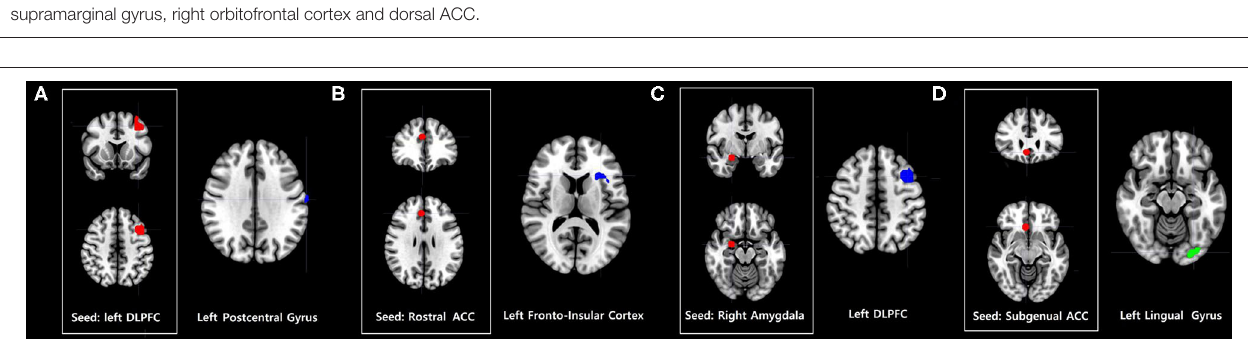
FIGURE 2 | Increases and decreases in seed-based FC among problematic smartphone users, compared to controls. All imaging analyses were corrected for multiple comparisons using a combination of voxel-level thresholds ( p < 0.001) and cluster extent threshold false discovery rate correction ( p < 0.05). (A–C) Brain regions with enhanced FC in problematic smartphone users, compared to controls. (A) Left dorsolateral prefrontal cortex (DLPFC)-based FC was increased with the left postcentral gyrus. (B) Right rostral anterior cingulate cortex (ACC)-based FC was increased with the left anterior frontoinsular cortex. (C) Right amygdala-based FC was increased with DLPFC. (D) Brain regions with decreased FC in problematic smartphone users, compared to controls. The right subgenual ACC and left lingual gyrus show differences in functional connectivity with right subgenual ACC-seeded analysis between the